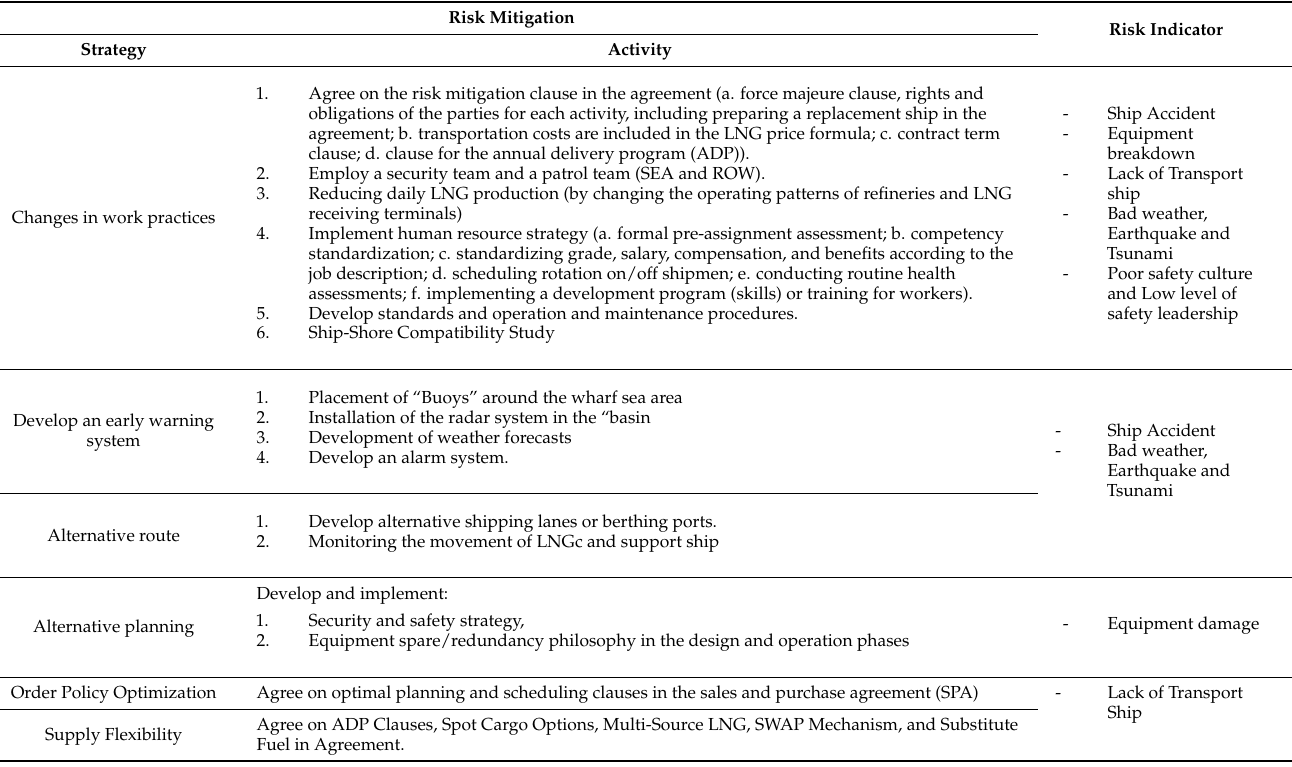
Table 6. Mitigation Activities in SS-LNG Activities Based on Risk